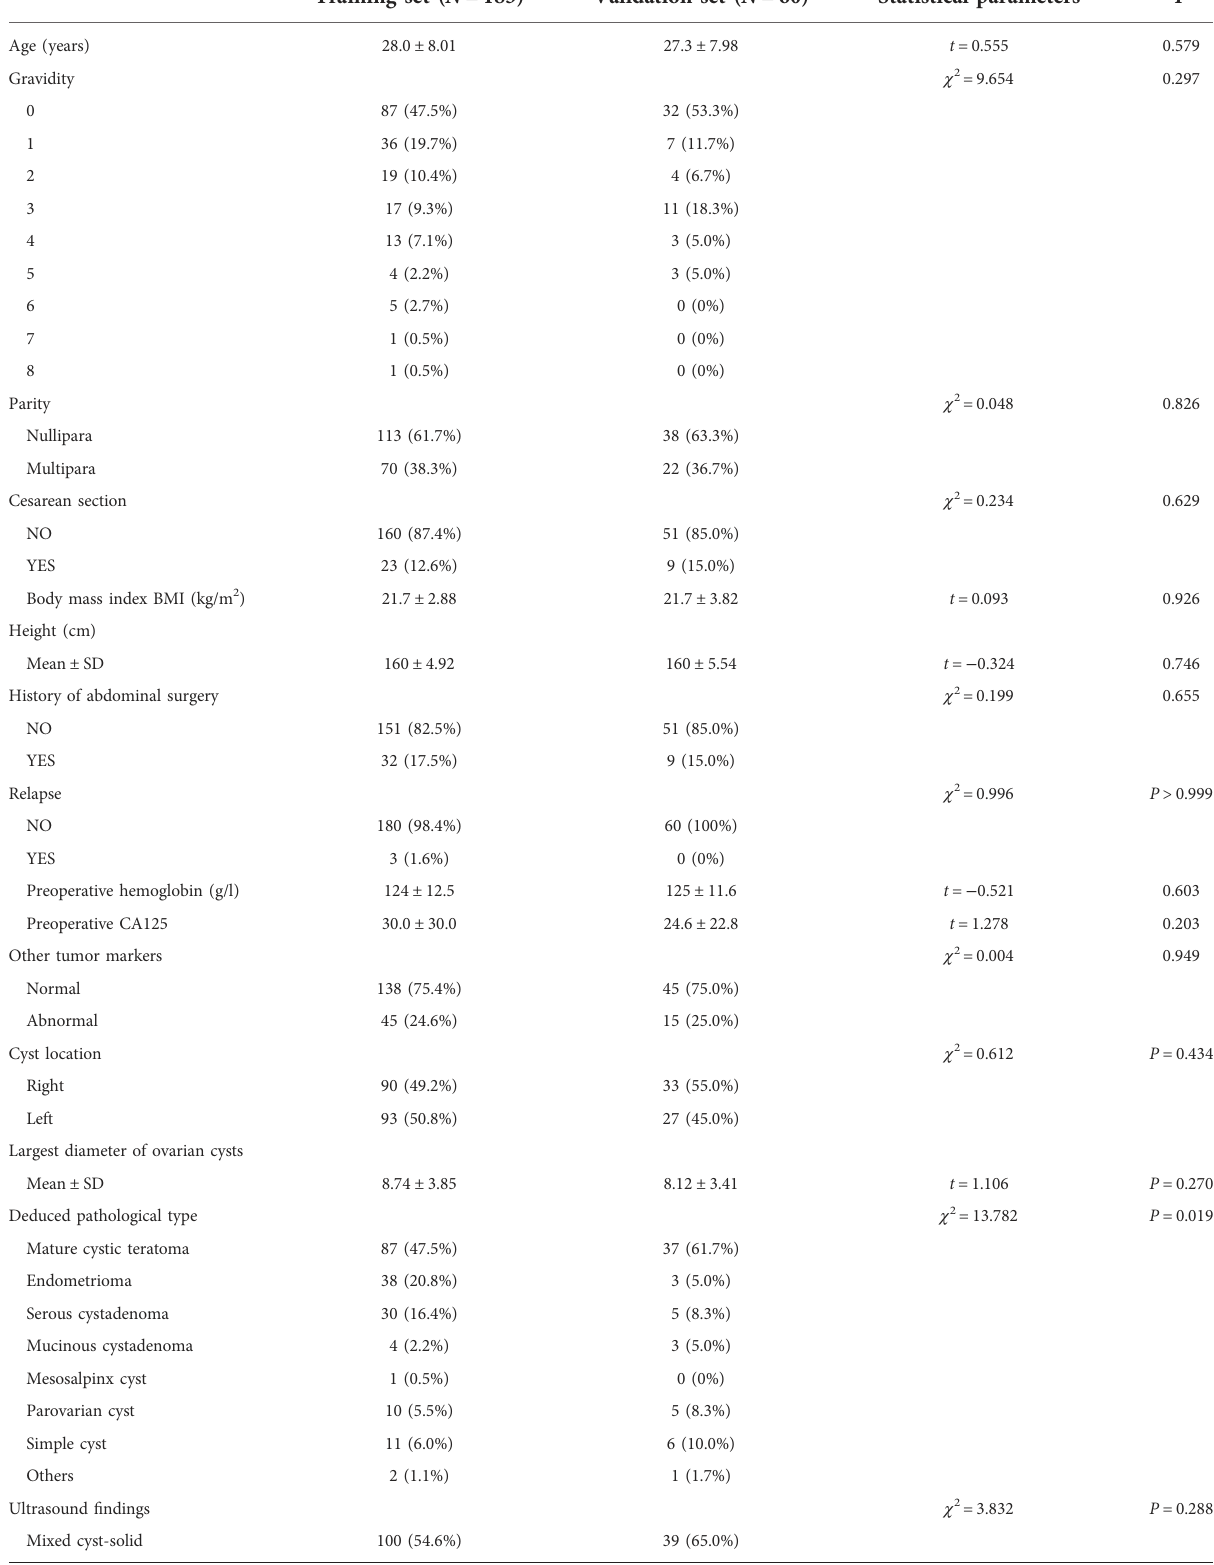
TABLE 1 Patient